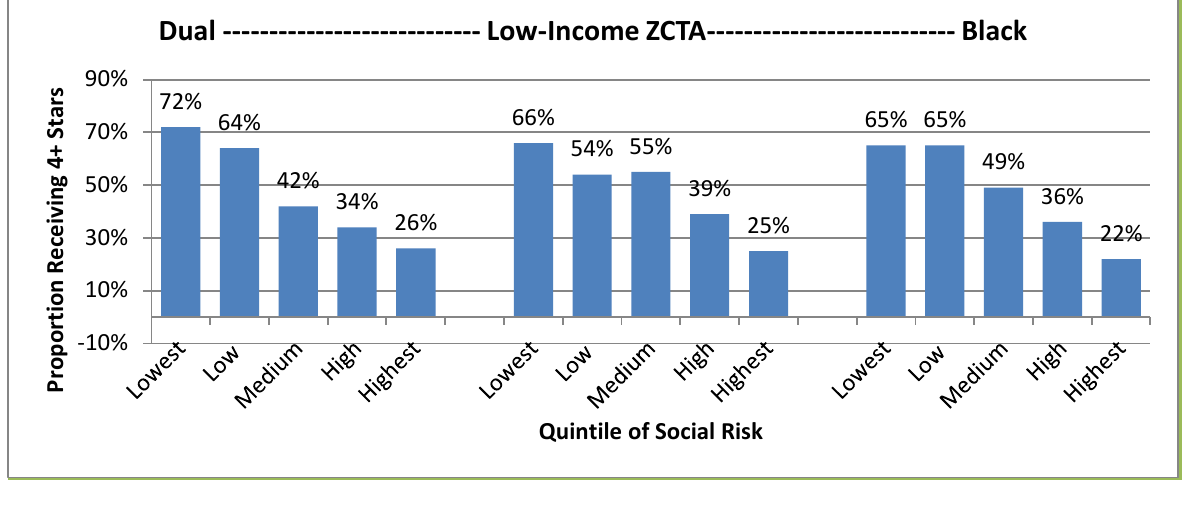
Figure 8.4: Contract Social Risk and Likelihood of Achieving Four or More